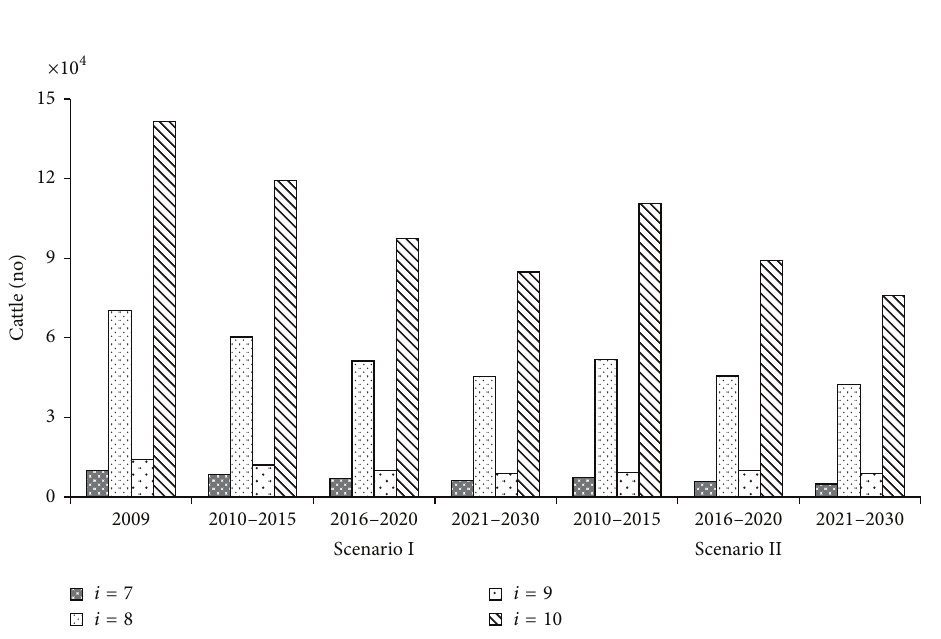
Figure 6: Planting types optimization results.